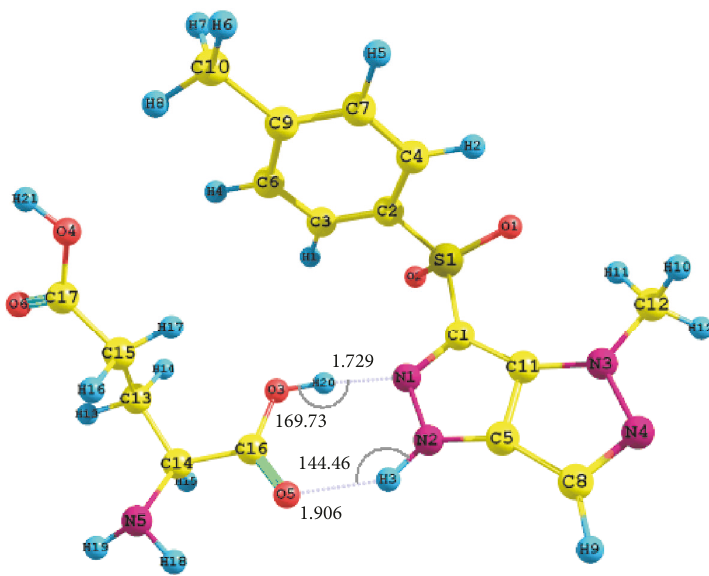
Figure 3: The optimized 7 –glutamic acid adduct 7Glu B